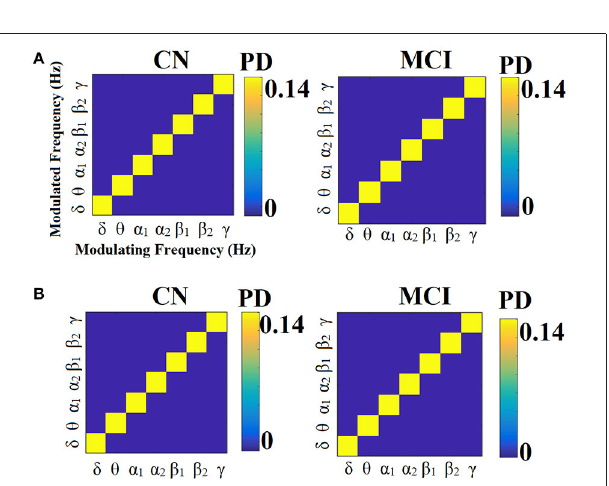
FIGURE 14 | Group-averaged comodulograms derived from ML-FCG iPLV . (A) PCA ROI representation. (B) Centroid ROI representation. PD, probability